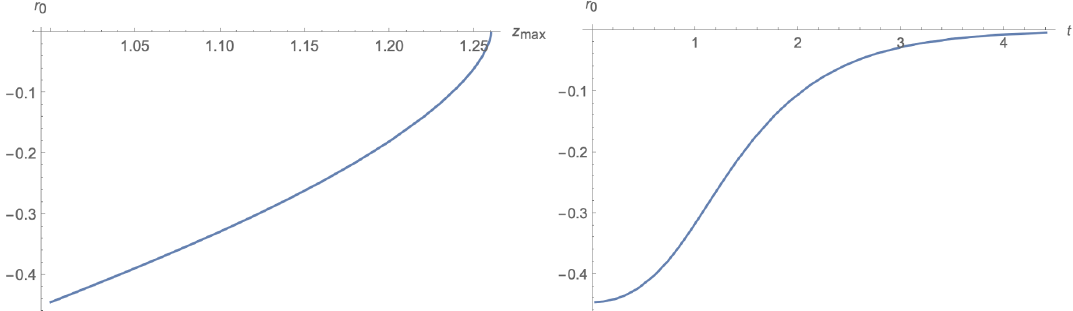
Figure 18 . Left: function r 0 ( z max ) ; right: function r 0 ( t ) . Note that z max = 1 corresponds to t = 0 and z max = 2 1 d − 1 ≈ 1 . 260 corresponds to t → ∞ . It shows that r 0 = r ( z max ) approaches zero in the large time limit.